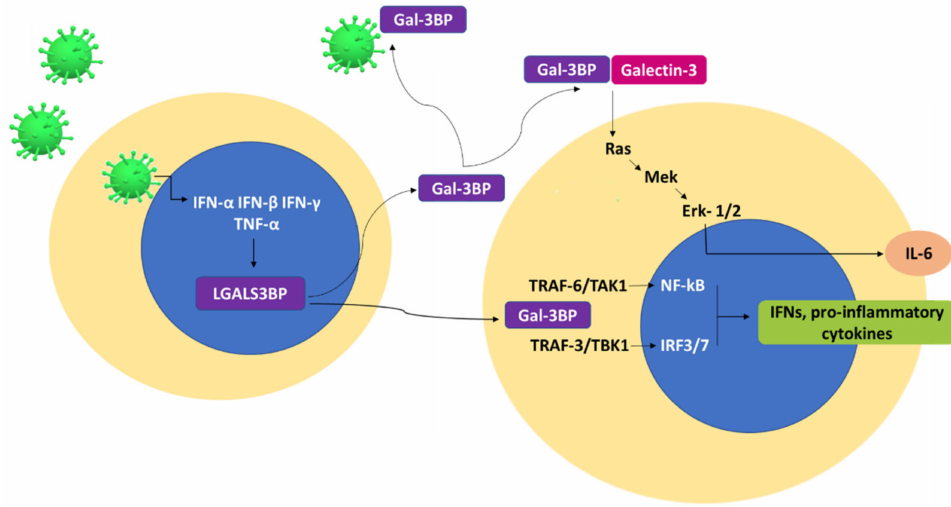
Figure 3. The figure shows some of the known interaction partners and signaling pathways of Gal-3BP, which lead to the expression of proinflammatory cytokines during virus infection. The viral DNA/RNA induces IFNs and TNF- α , that in turn induce Gal-3BP. The protein can act both intra- and extracellularly. Extracellularly, Gal-3BP can interact with galectin-3-inducing RAS-signaling pathway and IL-6 expression. Gal-3BP can also directly interact with virus particles reducing their infectivity. Intracellularly, Gal-3BP acts as a scaffold protein interacting with both TRAF-6/transforming growth factor β -activated kinase 1 (TAK1) and TRAF3/TANK binding kinase 1 (TBK1) complexes which leads to the production of IFNs and proinflammatory